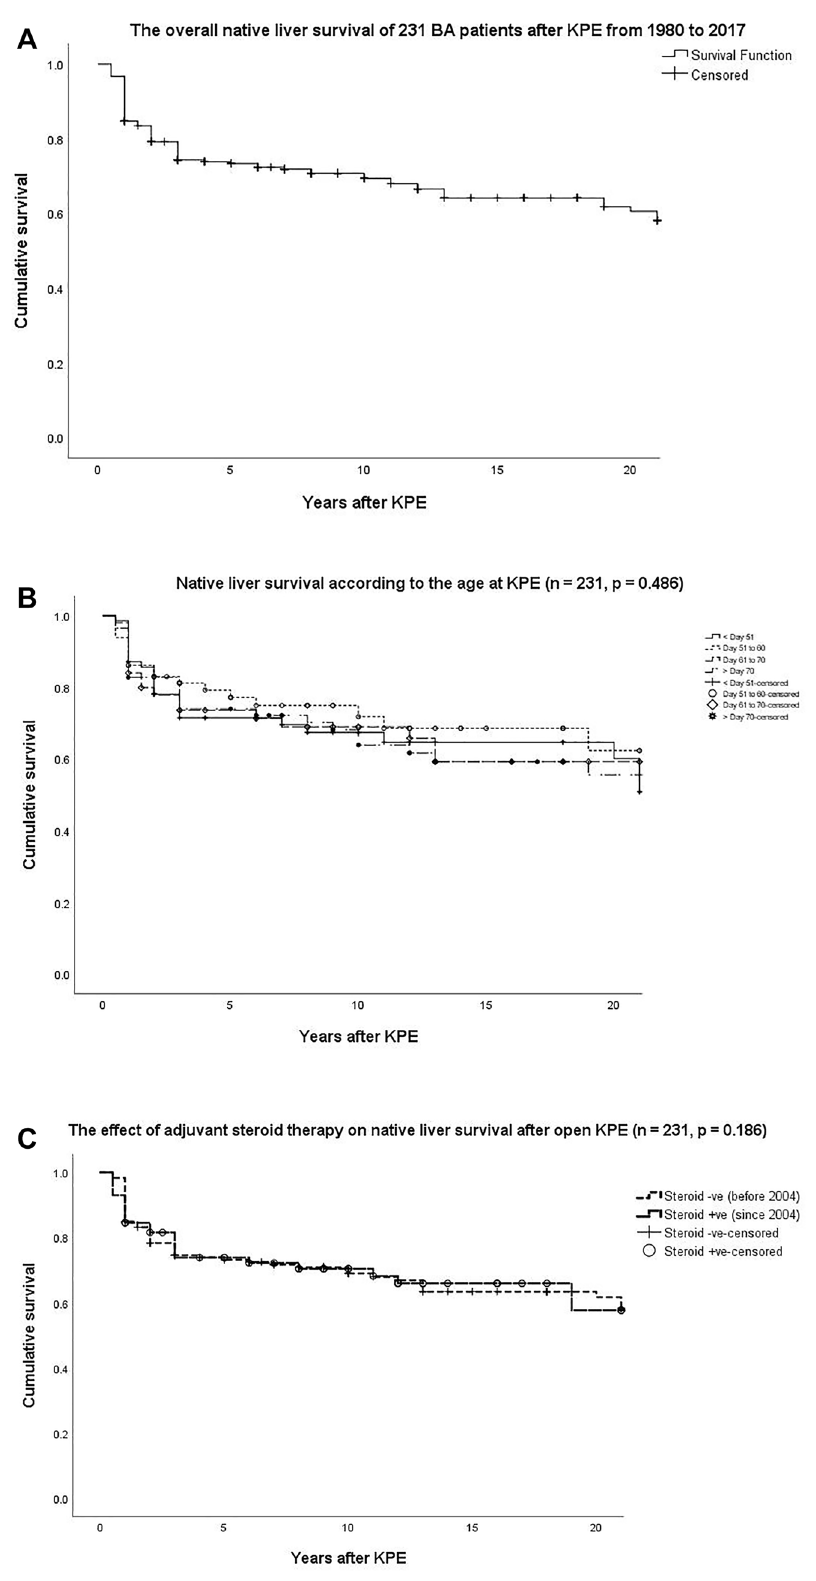
Figure 3. ( A ) The overall native liver survival of 231 BA patients after KPE from 180 to 2017. ( B ) Native liver survival according to the age at KPE (n = 231, p = 0.486). ( C ) The effect of adjuvant steroid therapy on native liver survival after open KPE (n = 231, p =